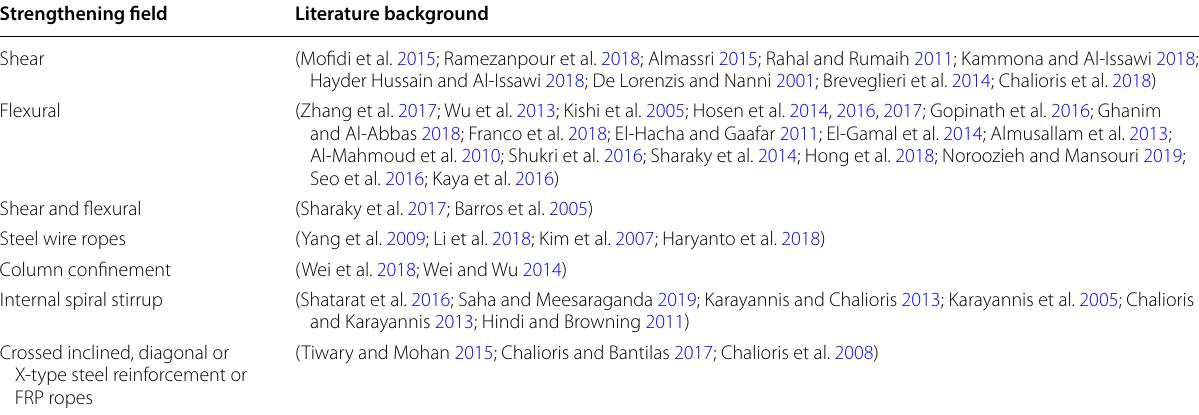
Table 1 NSM strengthening technique literature